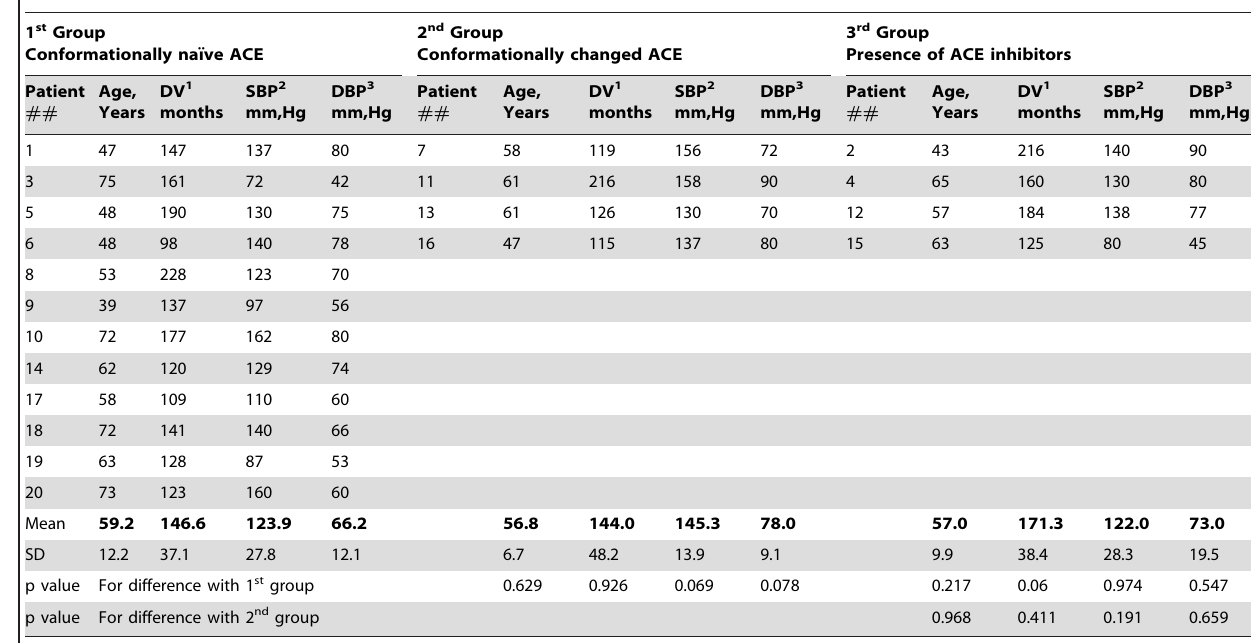
Table 1. Clinical Data.